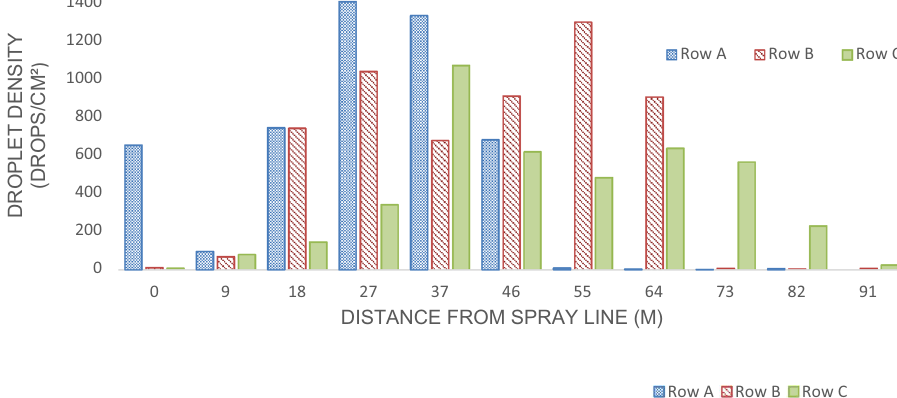
Fig. 5 Volume density and droplet sizes of VectoBac WDG applied using a truck-mounted A1 Super Duty Mister sprayer at 560 g/ha in an open